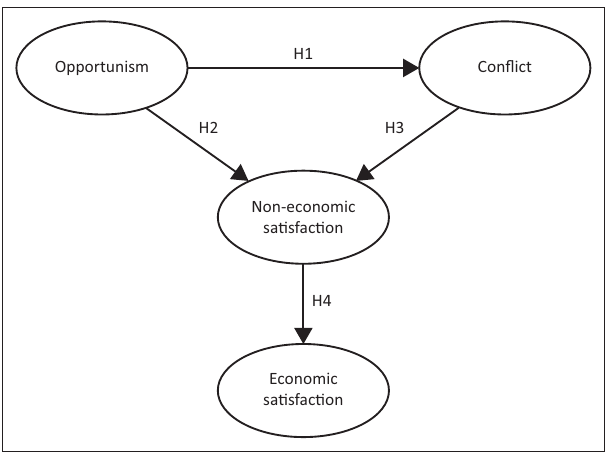
FIGURE 1: Proposed research